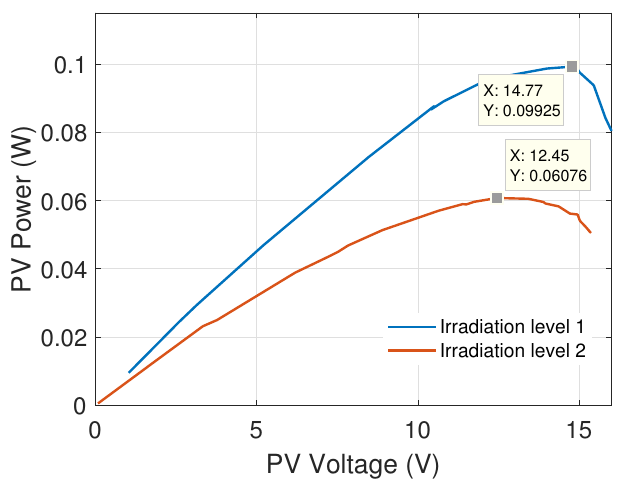
Figure 11. Experimental PV power vs. PV voltage characteristic curve for two irradiation levels.